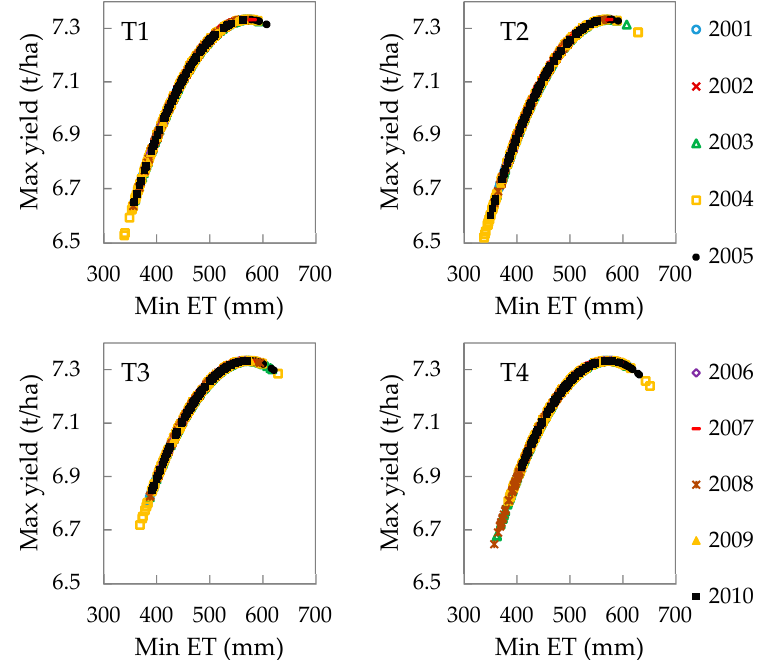
Figure 6. Relationship curves between maximal crop yield and minimal crop water consumption